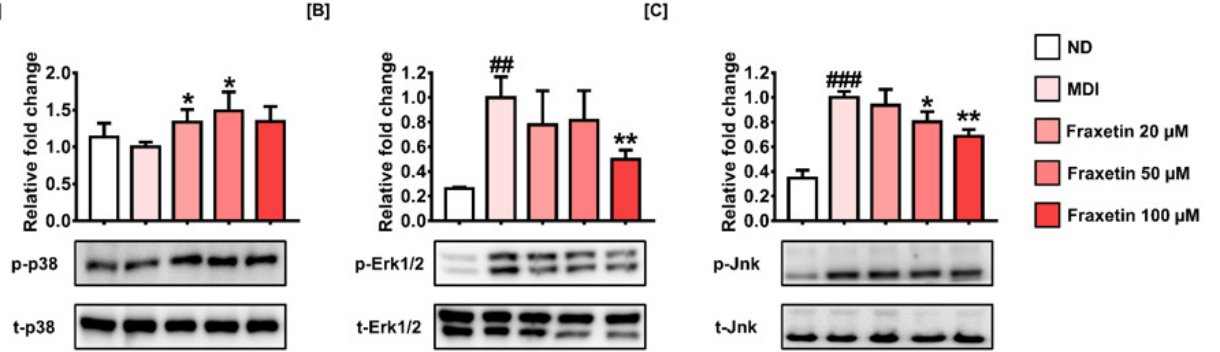
Figure 6. Effect of fraxetin on the regulation of adipogenesis through MAPK signaling. The protein expressions of the MAPK signaling pathway, including ( A ) p38, ( B ) Erk1/2, and ( C ) Jnk phosphorylation, were analyzed with Western blotting. Each phosphorylation level was normalized with each total protein level. All data were obtained in triplicate. The asterisk symbol represents significant differences between the MDI-treated group and others (* p < 0.05, ** p < 0.01). The crosshatch symbol represents meaningful differences among the nondifferentiated group and others (## p < 0.01, ### p < 0.001), as verified using one-way analysis of variance (ANOVA), followed by Dunnett’s post hoc analysis.